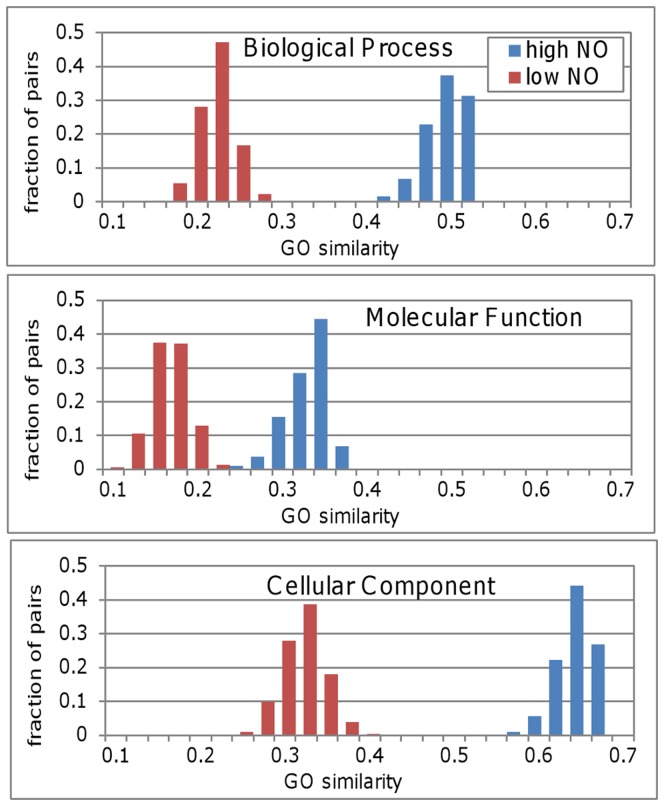
GO annotation similarity for high and low Neighbor Overlap groups.The distributions in each panel represent the GO annotation similarity of 1000 subsets each of size 100) from the high (blue bars) and low (red bars) Neighbor Overlap groups. The distributions for the three ontologies: Biological Process (top), Molecular Function (middle) and Cellular Component (bottom) show a marked separation between their GO similarities for pairs with high and low NO values.